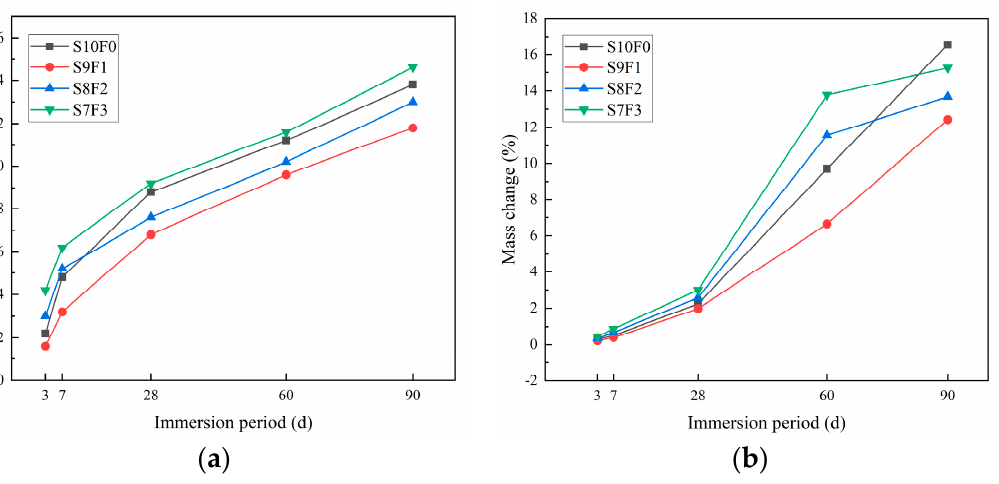
Figure 7. Mass change in SF-GSSS at di ff erent immersion periods: ( a ) Na 2 SO 4 solution and ( b ) MgSO 4 solution.